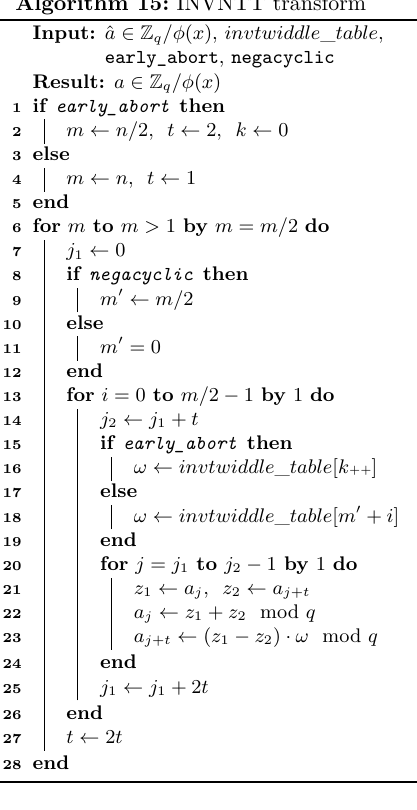
Algorithm 14: NTT transform